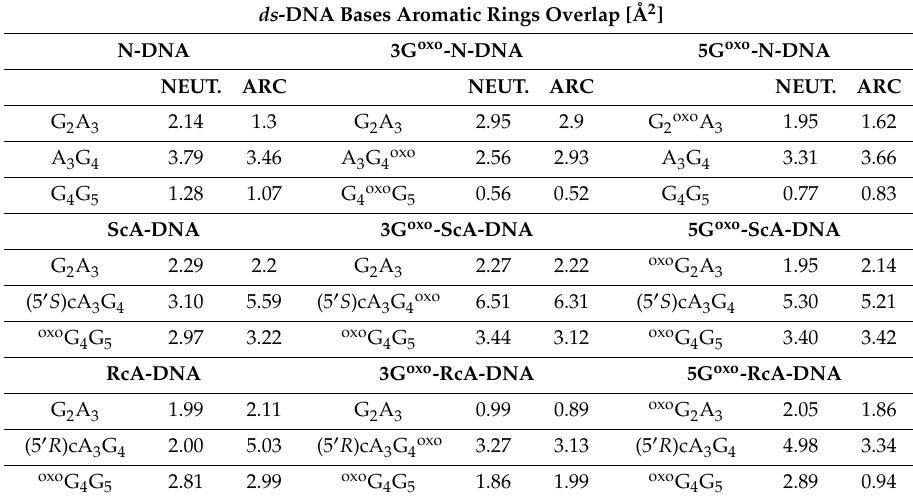
Table 3. Aromatic ring overlapping of the base pair dimers of the discussed ds -oligonucleotides in their neutral (Neut.) and adiabatic radical cation (ARC) form